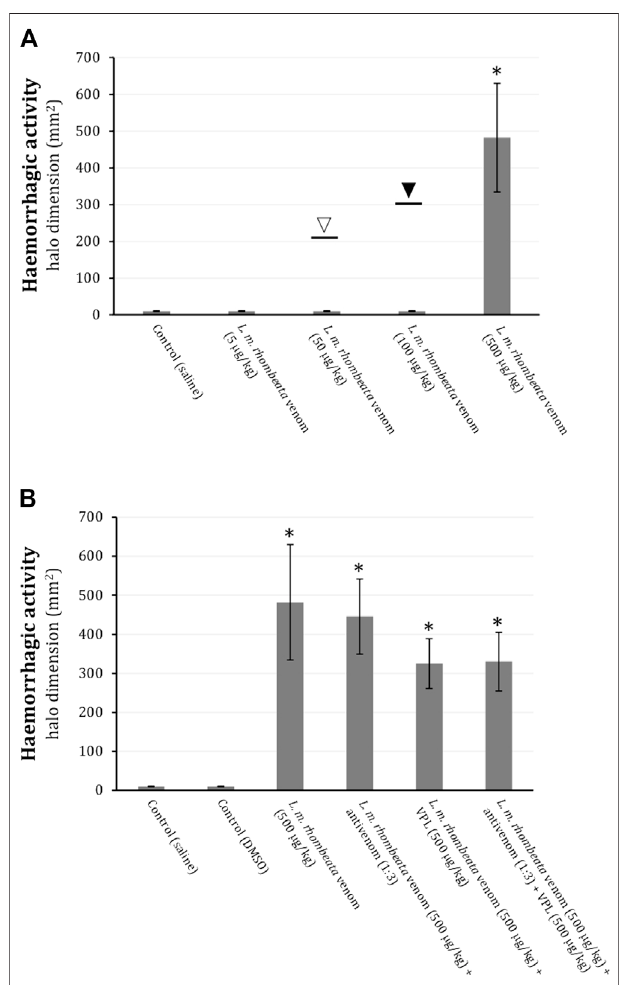
FIGURE 3 | Action of varespladib on the haemorrhagic activity of L. m. rhombeata venom in rats. (A) L. m rhombeata venom produced intense subcutaneoushaemorrhageatadoseof500 μ gofvenom/kg,withthelowest doses (5, 50, and 100 μ g/kg) being ineffective toproduce haemorrhage; the opened and fi lled arrows indicate the haemorrhagic dimension caused in single animals envenomed with 50 and 100 μ g of venom/kg, respectively. (B) Antivenom did not prevent the venom-induced subcutaneous haemorrhage, with varespladib alone or combined with antivenom producing discreet reduction of this alteration. Bars represent the mean ± SDM ( n (cid:1) 6). * p < 0.05 compared to control